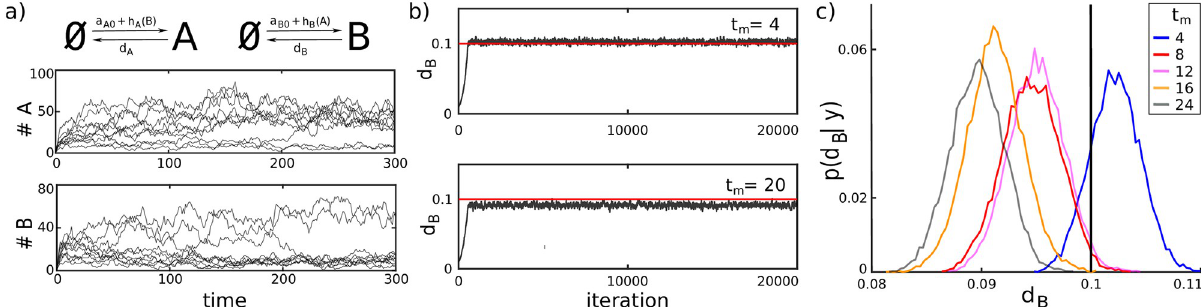
Fig 3. Parameter inference for a genetic toggle switch using the LNA in Algorithm 1. a) N = 10 system trajectories obtained using Gillespie’s stochastic simulation algorithm. b) The MCMC search (20000 steps) with data from N = 10 cells measured every t units shows fast convergence from an initial guess of d B = 0.01 to an approximated posterior distribution whose maximum is close to, but not exactly at, the true parameter value. The error is larger for the case where t m = 20. c) Posterior distributions for different values of t m : t m = 4 (blue), t m = 8 (red), t m = 12 (purple), t = 16 (orange), t = 20 (grey). All distributions were obtained as histograms of the values visited by the corresponding Markov chain m m with a burn in period of 1000 steps. The magnitude of the error of the MAP estimator tends to become larger with increasing t m as expected from the increasing error of the employed likelihood approximation. Parameters for this case study have been chosen as a k B = 100, n A = n B = 2, and d A = d B = 0.1, A (0) = B (0) = 1, σ = 4, t S = 300 all in arbitrary or no units. The model is given in